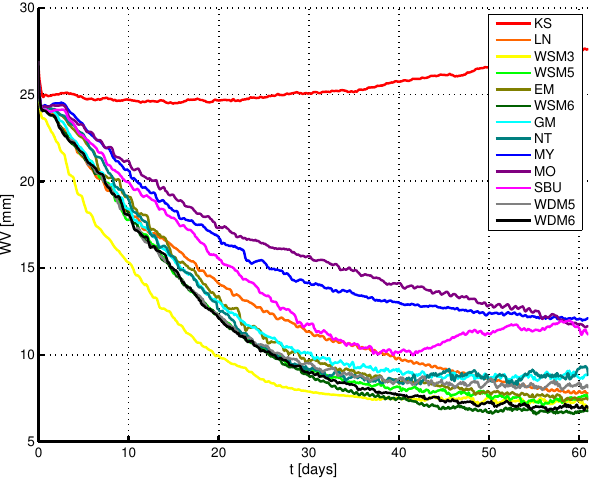
Fig. 5. Comparison of hydrometeor mean column density for the 13 microphysical schemes. To enhance the differences between the schemes, the series have been filtered with a 10-day lowpass